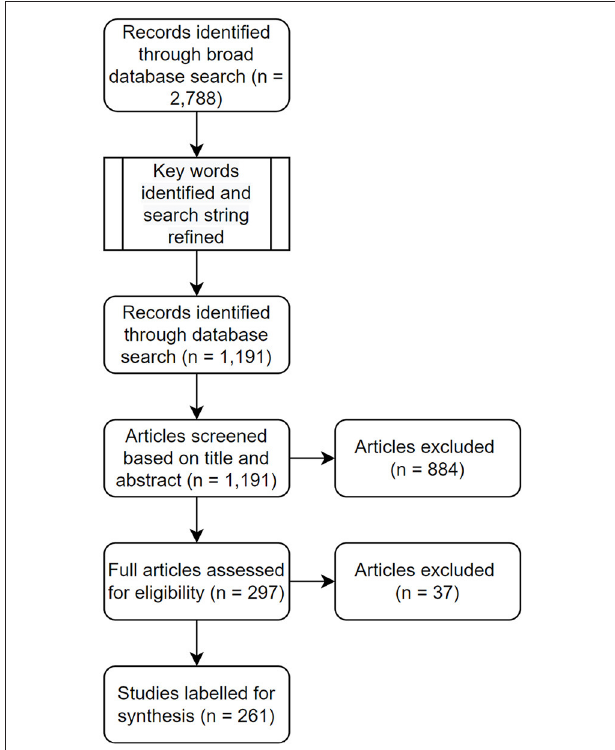
FIGURE 1 | PRISMA diagram illustrating the article selection process.